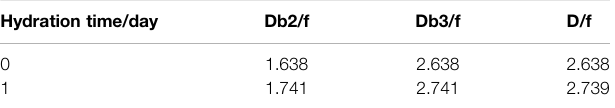
TABLE 3| PMsfractaldimensionscalculatedbycumulativeprobabilitymodeland box-counting method. Hydration